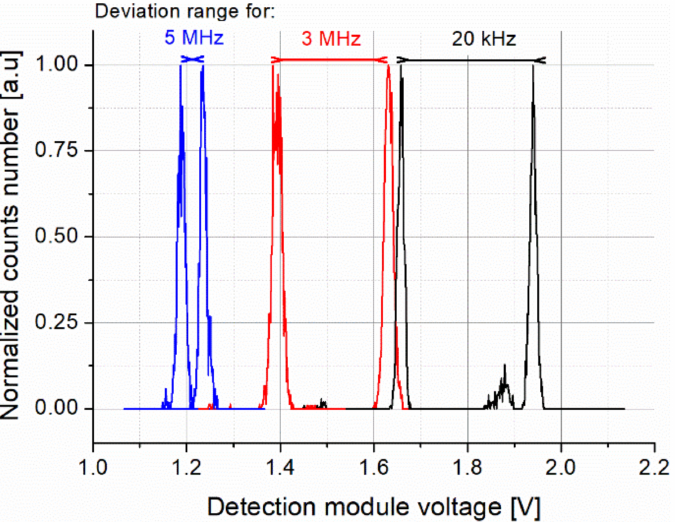
Figure 10. Deviation ranges of the optical pulse amplitude for different repetition rates.